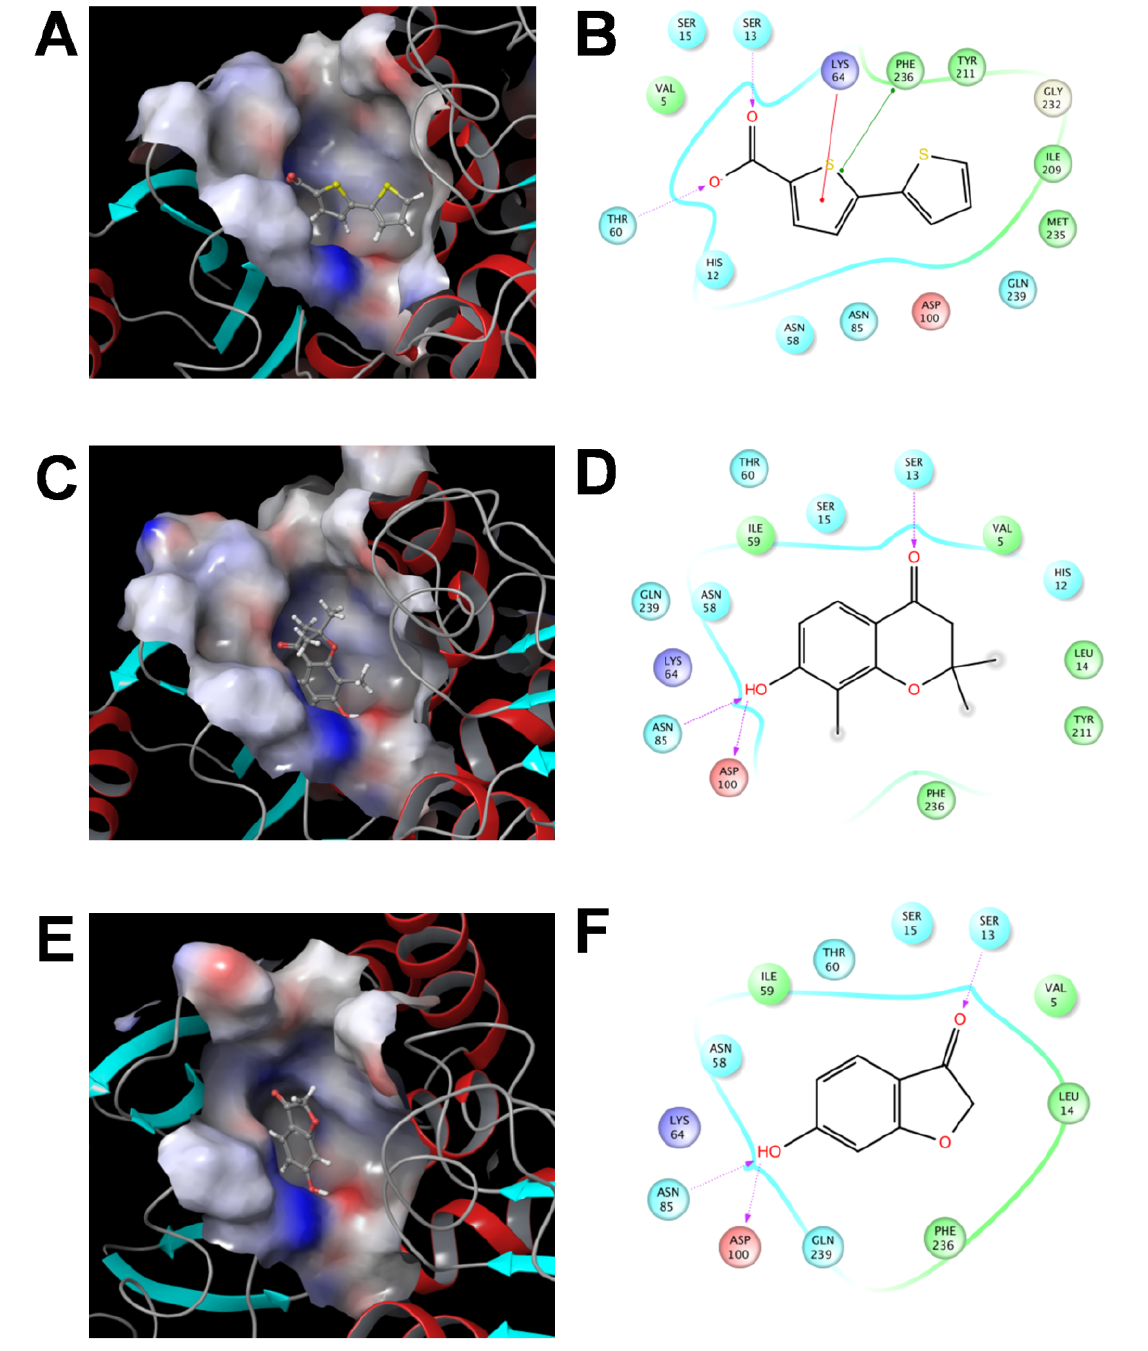
Figure 5. 2D and 3D plots showing binding of compounds 238 , 766 and 894 ( A , C and E , respectively) to the SaSDH active site (showing electrostatic surface; neutral residues are depicted in white, while negative and positive charged residues are colored in red and blue respectively), showing interactions between the enzyme and compounds 238 , 766 and 894 ( B , D and F , respectively). Dashed lines with arrow heads indicate H-bond formation; single dots indicate cation-pi interactions, and dots in both extremes of the line indicate pi-pi